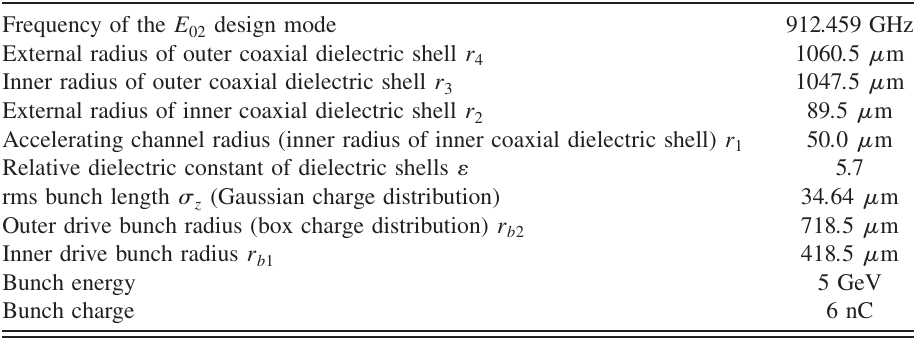
TABLE I. Parameters for a two-channel coaxial dielectric wakefield accelerator module. design Frequency of the E 02